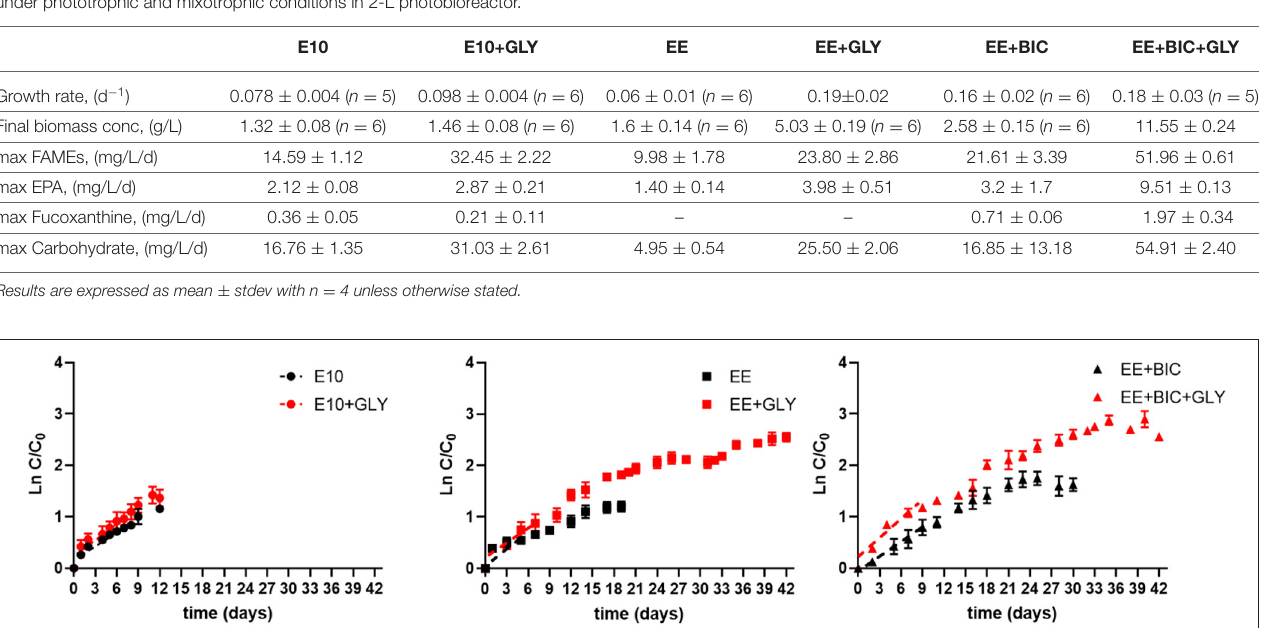
TABLE 4 | Growth rate, final biomass concentration, maximum FAMEs, EPA, fucoxanthin, and carbohydrate productivity in the different media, E10, EE, and EE+BIC under phototrophic and mixotrophic conditions in 2-L photobioreactor.